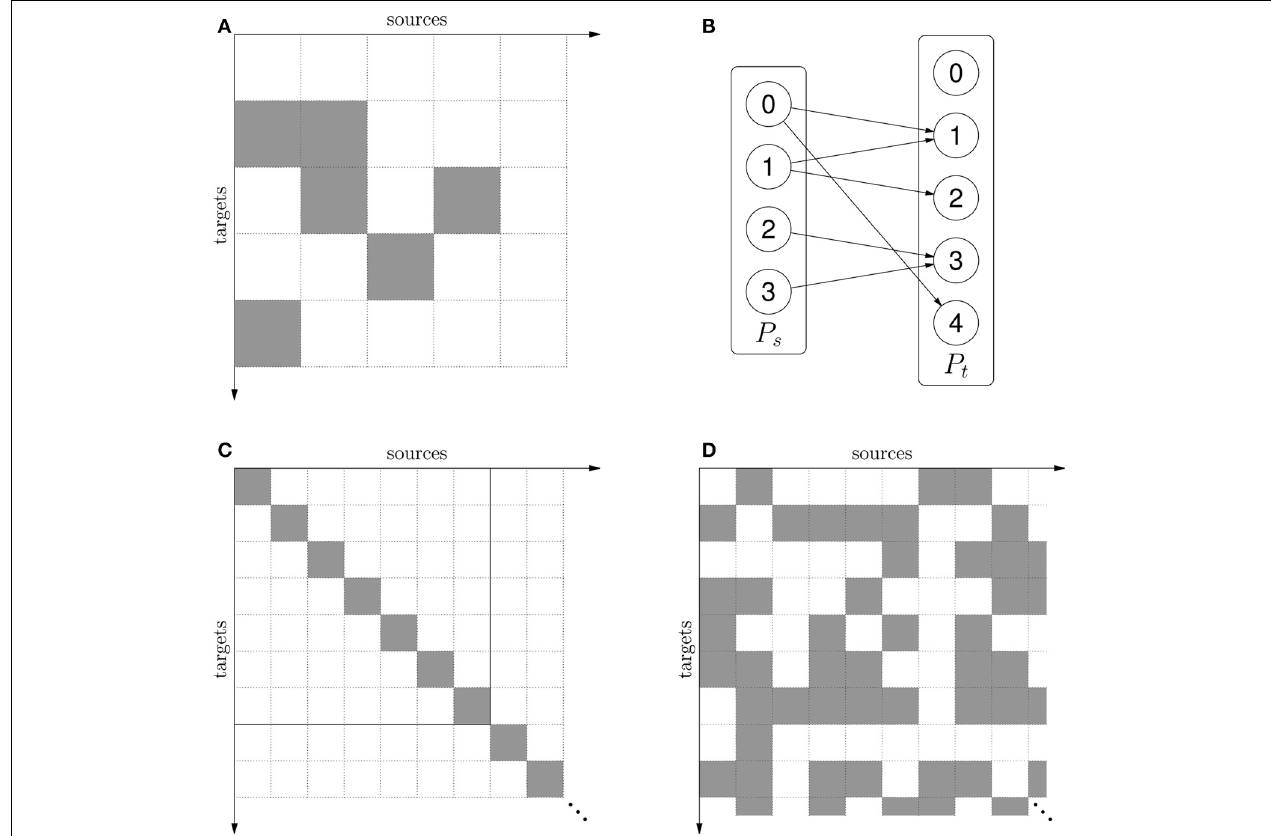
FIGURE 2 | (A) The mask M = { (0 , 1) , (1 , 1) , (1 , 2) , (3 , 2) , (2 , 3) , (0 , 4) } shown as a connection matrix. Gray squares represent existing connections. (B) Network connectivity when the mask in (A) is applied to source population P s and target population P t . (C) The one-to-one mask ¯ δ . The mask is infinite, but